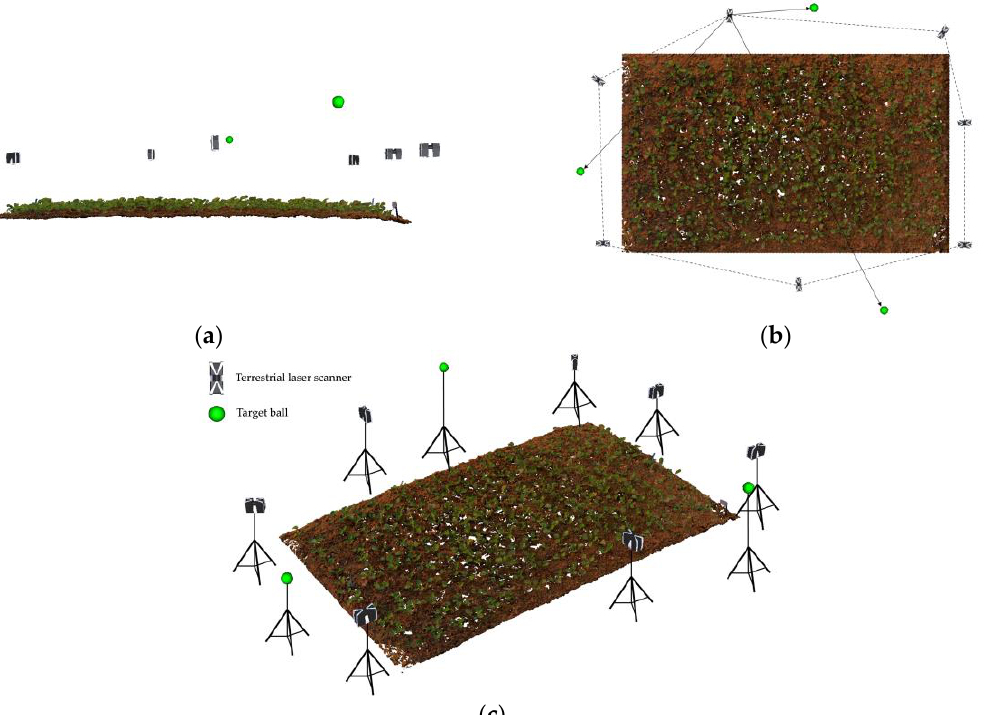
Figure 2. Point cloud acquisition method for Rapeseed-01 in the field. ( a ) Right view; ( b ) Vertical view; ( c ) Isoaxometric left view.